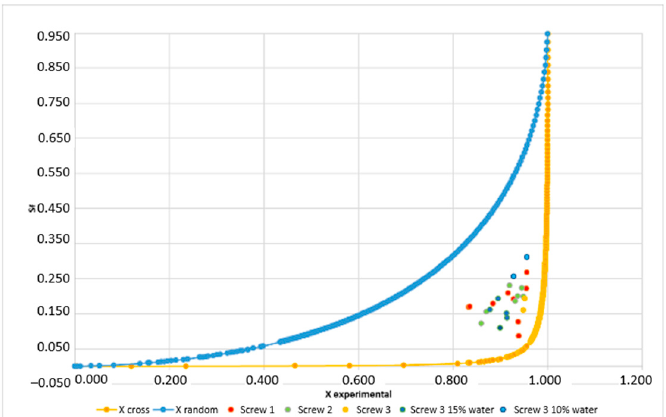
Figure 8. Horikx plot: red circles represent samples devulcanized using screw 1, green circles screw 2, yellow circles screw 3, light blue circles screw 3 10% H 2 O, dark blue circles screw 3 15% H 2 O. Blue line refers to the random model and orange line to the crosslinking scission model according to Horikx models.